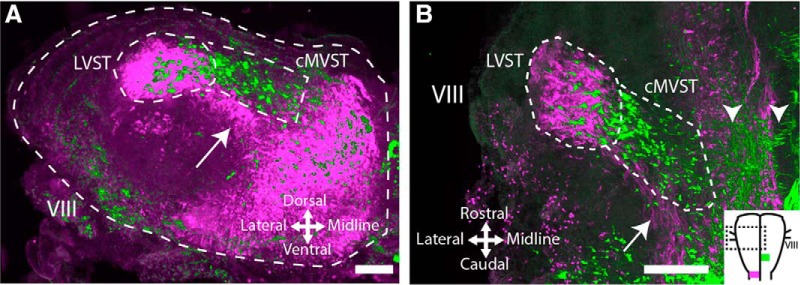
Spatial relationship between LVST and cMVST neuron groups. Differential retrograde labeling in the E13.5 mouse of LVST with RDA (pseudocolored magenta; applied unilaterally at C1), and cMVST with BDA/FDA (pseudocolored green; applied contralaterally at mid-medulla; B, inset). Structures visible in the green channel have been superpositioned on structures visible in the magenta channel for clarity. A, Overlay of 17 serial transverse sections spanning the rostrocaudal extent of the LVST/cMVST groups. Dotted white outlines show the section perimeter (outer) and the principal domains of the LVST and cMVST groups. LVST axons (arrow) course medioventrally to the LVST group. In this preparation, only 26 of 44 cMVST neurons that appear to be within the domain of the LVST group in the image projection are in fact intermingled with LVST neurons; the remainder actually lies outside the LVST group domain. B, Overlay of nine frontal sections spanning the dorsoventral extent of the LVST/cMVST groups. LVST axons (arrow) course mediocaudally to the LVST group. Arrowheads indicate cMVST axons crossing the midline. In the inset, the dashed box shows the location of the full image, and magenta and green indicate dextran amine injection sites. VIII, Eighth cranial nerve entry site. Scale bar, 200 μm. See Figure 1-1, retrograde labeling from the mid-medulla does not label outside of the cMVST group.